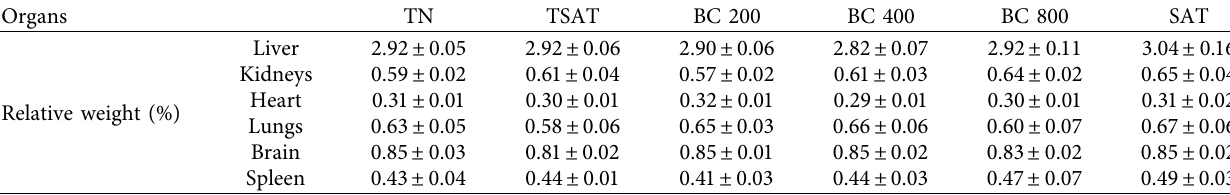
Each value represents the mean ± SEM, n � 5. TN: normal rats receiving distilled water (10mL/kg); TSAT: normal satellite observed 14 more days after stopping every treatment; BC 200, BC 400, and BC 800: animals receiving the aqueous extract of the mixture of B. pilosa and C. citratus at the respective doses of 200, 400, and 800mg/kg; SAT: satellite extract at the dose of 800mg/kg observed 14 days after stopping every treatment. Table 3: Efects of the plant mixture aqueous extract on the relative weight of the organs of males. Organs TN TSAT SAT Liver Relative weight (%)